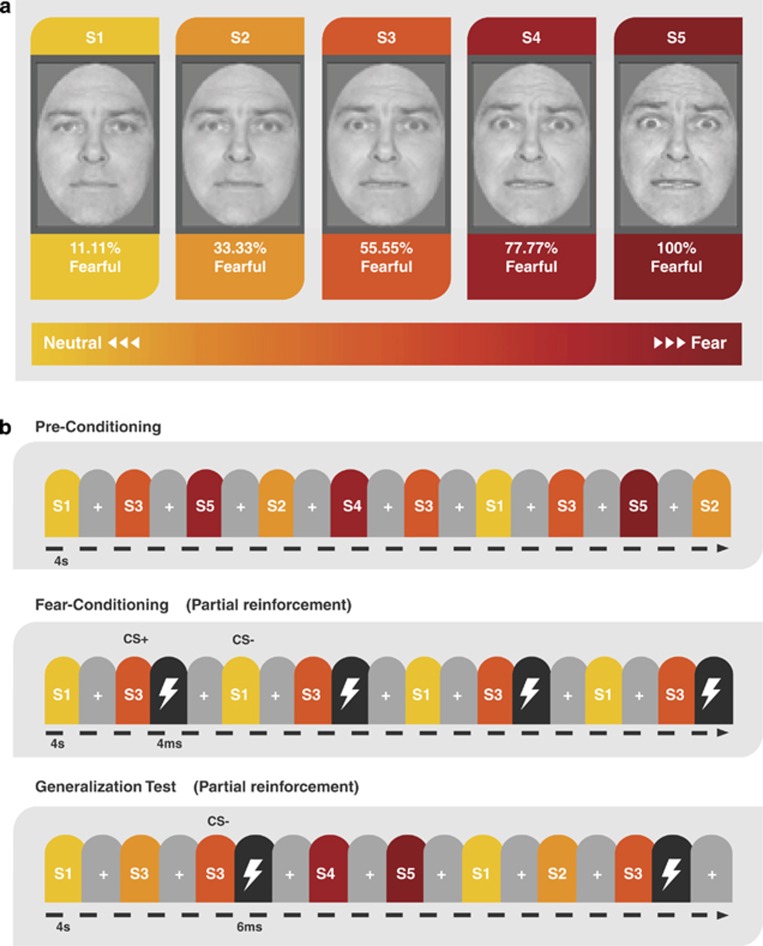
Stimuli and task design. (a) Generalization was assessed with images of five facial morphs of the same identity that ranged from neutral-to-fearful end points. (b) During preconditioning, participants were exposed to all the five facial morphs before fear conditioning to assess the baseline behavioral and neural responses. Fear learning was accomplished in two runs by pairing an electrical shock (US) with presentation of the S3 morph (CS+) on 6 out of 18 trials (33%), whereas S1 was never paired with shock (CS−). Morphs S2, S4 and S5 were not presented during fear conditioning. During four runs of the generalization test, all the five morphs (S1–S5) were presented and S3 was intermittently reinforced with a shock (4 of 12 trials; 33%). US, unconditioned stimulus.